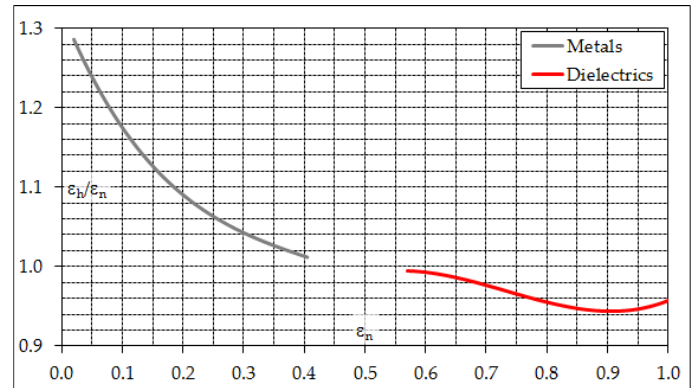
Figure 13. Hemispherical vs. near-normal emittance.